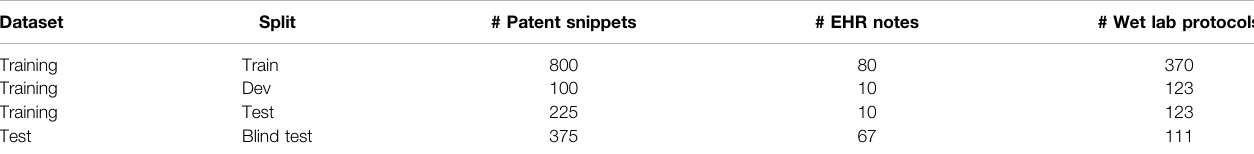
TABLE 5 | Distribution of samples in the train, dev, and test collections for the different NER tasks. Train: collection used to train model parameters. Dev: collection used to tune model hyperparameters. Test: collection used to de fi ne the ensemble models. Blind test: collection used to evaluate models. Dataset